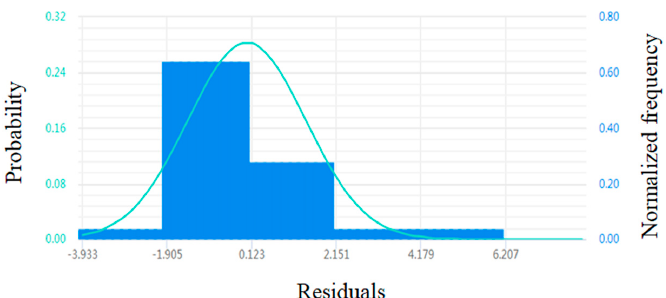
Figure 19. Normal distribution of residual data.